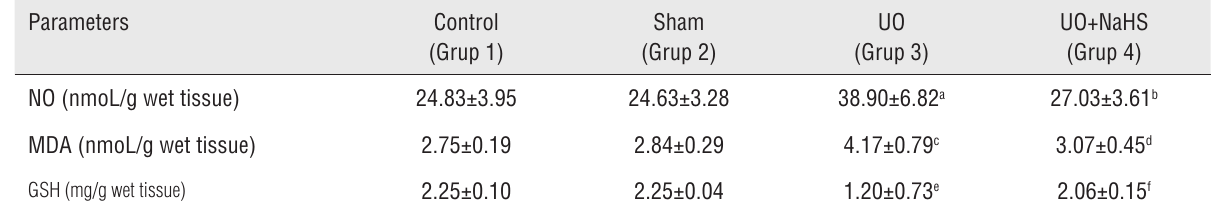
Table 2 - Effect of h